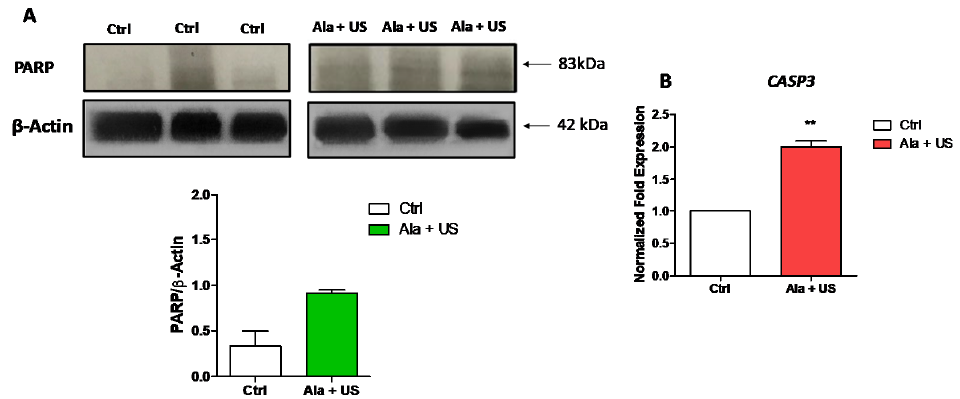
Figure 2. PARP cleavage and CASP3 mRNA expression after SDT. Control and experimental groups were either treated with a saline iv injection into the tail vein (0.5 mL), an Ala iv injection into the tail vein (375 mg/kg bw), US alone (1.5 W cm2, 1.8 MHz, 300 s), or Ala and US (1.5 Wcm 2 , 1.8 MHz for 300 s, at 4 h after the Ala 375 mg/kg bw iv injection, SDT group). ( A ) Representative Western blots of PARP at 72 h after SDT indicate PARP cleavage to 83 KDa. Histograms show densitometric analysis normalized to the corresponding β-actin content. ( B ) CASP3 mRNA expression by RT-PCR was analyzed at 72 h after SDT. RRN18S was used as a reference gene to normalize the data (mRNA levels were compared with those of the control group, stated as 1). Statistical significance vs. untreated tissue (Ctrl): ** p ≤